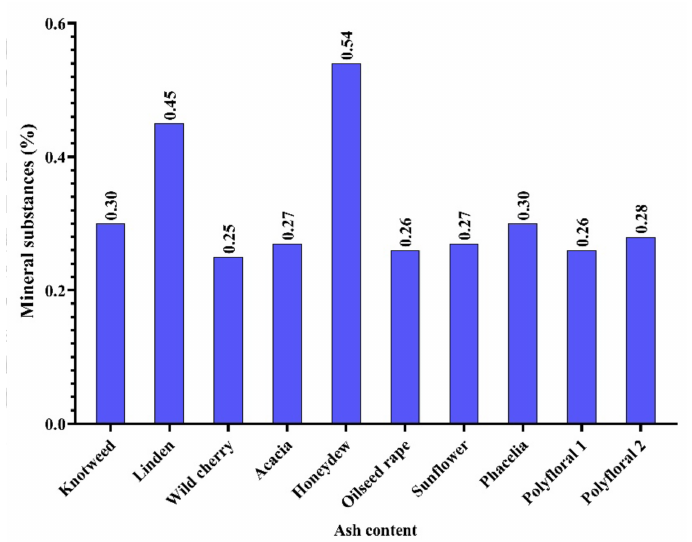
Figure 2. Mineral substance (ash) content (%).